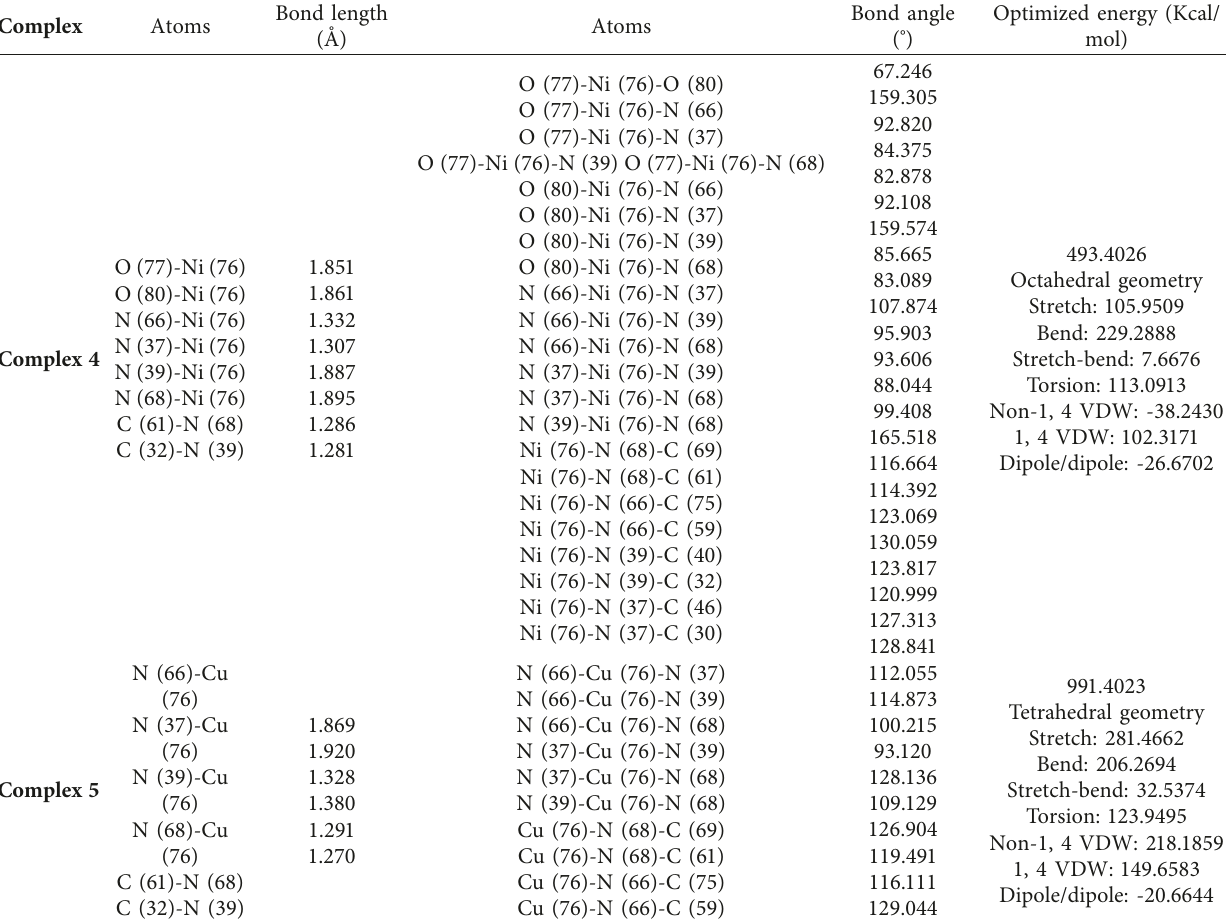
Table 3: Selected bond lengths, bond angles, and energy parameters of metal